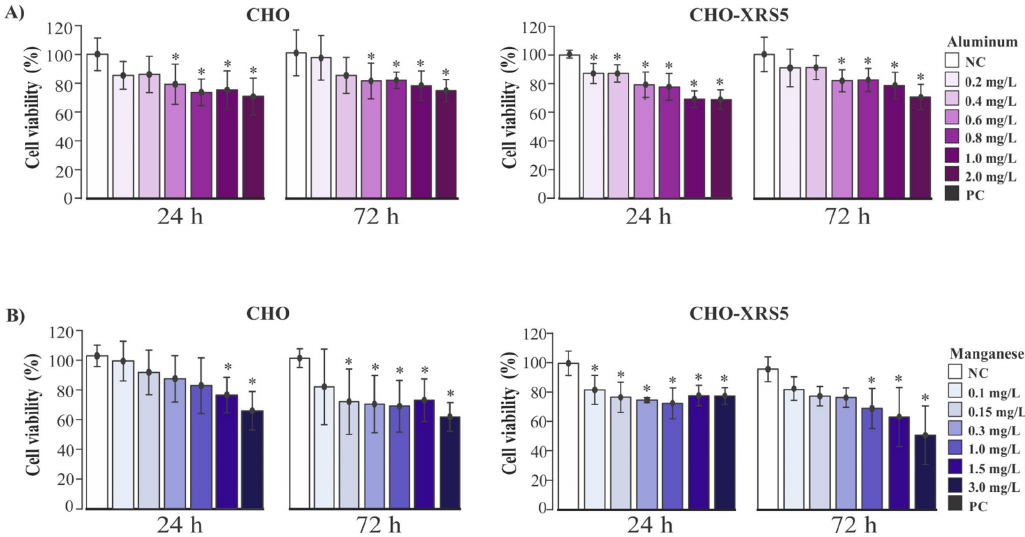
Figure 1. Viability (%) of Chinese hamster ovary (CHO) and CHO-XRS5 cells. Cells were treated with different concen- trations of aluminum ( A ) and manganese ( B ) for 24 and 72 h. Data are expressed as means ± standard deviation of three independent experiments performed in triplicates. * p < 0.05 compared to the negative control by the analysis of variance test followed by Tukey’s test. NC, negative